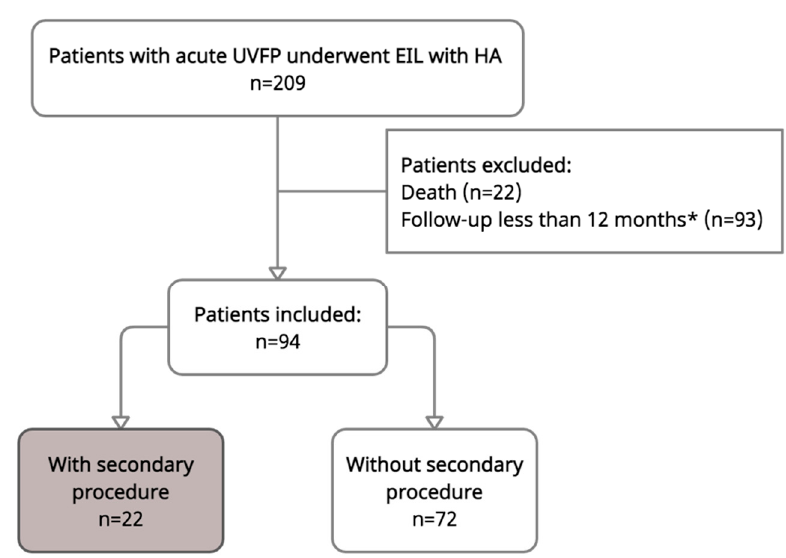
Figure 2. Flowchart illustrating inclusion/exclusion of the study population. EIL = early injection laryngoplasty. * By telephone consultation: patients with good voice ( n = 37); patients with worsened voice ( n = 9); not reachable ( n = 47). Table 1. Patient demographics and comparisons between patients with and without secondary procedures ( n = 94). n (%) or Mean (95% CI) Secondary Procedures None p -Value n = 94 n = 22 n = 72